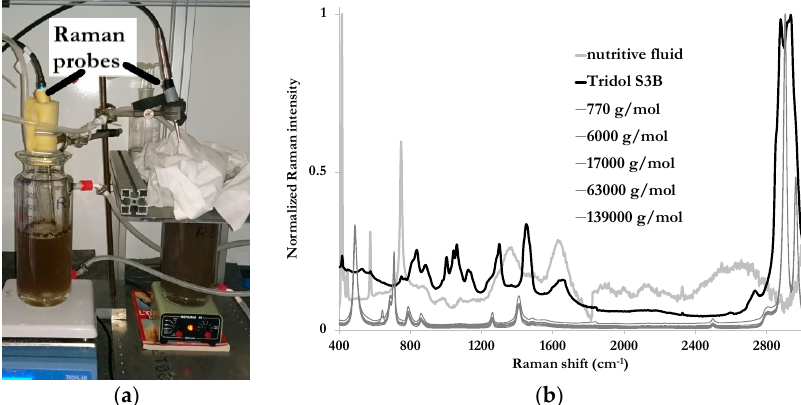
Figure 3. Experimental setup with Raman immersion probes into two identical environmental matrices (one reactor without polyfluoroalkyl ether on the left, and with polyfluoroalkyl ether on the right of the picture) ( a ), and Raman spectra of each fluid constituting the environmental matrix before addition of the inoculum ( b ).